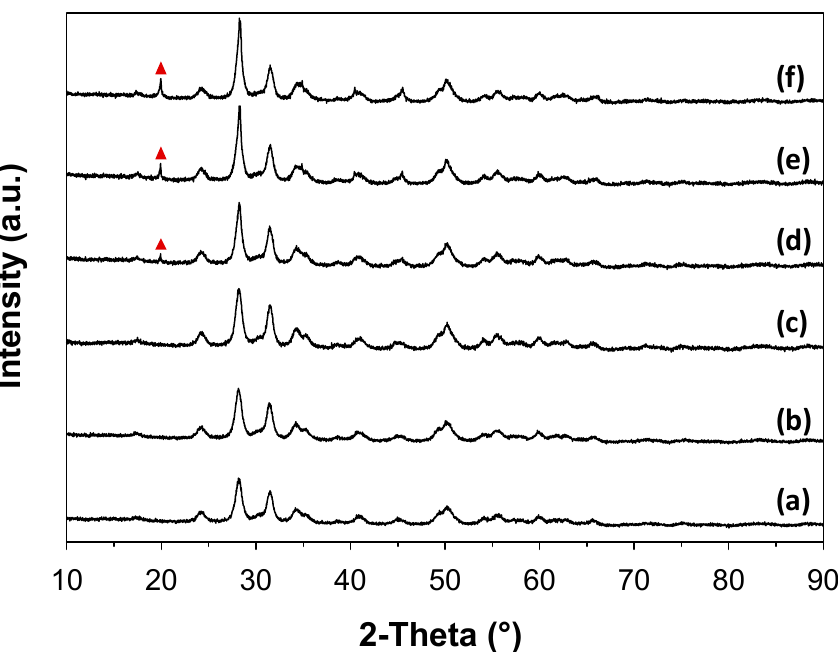
Figure 1. XRD for ( a ) ZrO 2 , ( b ) 2% Pt/ZrO 2 , ( c ) 0.72% Cs-2% Pt/ZrO 2 , ( d ) 2.9% Cs-2% Pt/ZrO 2 , ( e ) 5.8% Cs-2% Pt/ZrO 2 , and ( f ) 14.5% Cs-2% Pt/ZrO 2 .